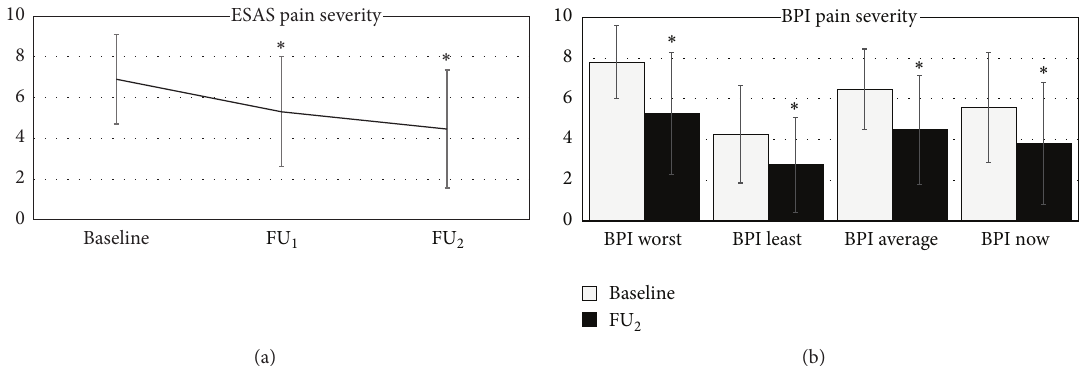
Figure 1: ((a) and (b)) Pain severity along the course of the study. Statistically significant and clinically meaningful reductions were observed between baseline and FU 2 in all pain questionnaires rating pain intensity (ESAS 𝑝 = 0.0000001 ; BPI worst 𝑝 = 0.00000006 ; BPI least 𝑝 = 0.0005 ; average pain 𝑝 = 0.00004 ; pain now 𝑝 = 0.0006 ). Values depict average and standard deviation. ∗ Paired 𝑡 -tests compared with baseline, 𝑝 value < 0.05.